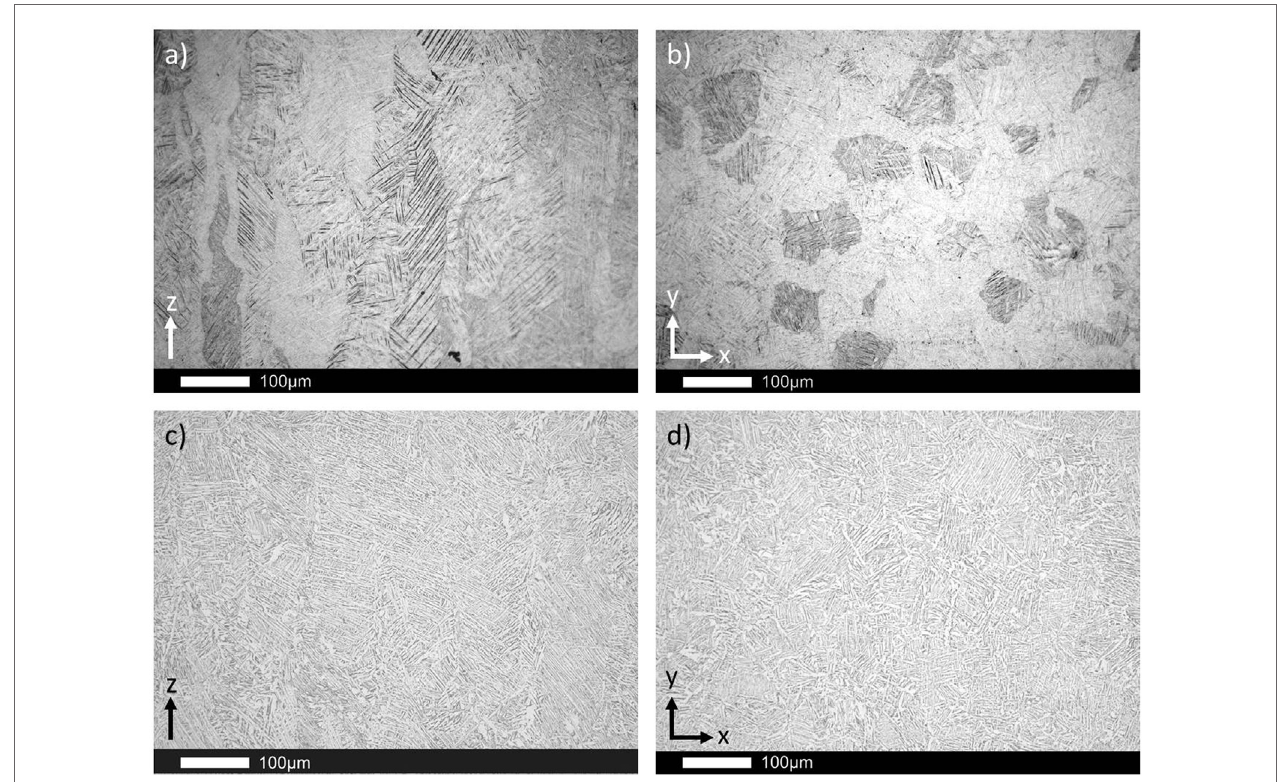
FigUre 1 | Microstructure of laser additive manufactured Ti–6al–4V in stress-relieved (a,B) and hot-isostatic-pressed (c,D) condition